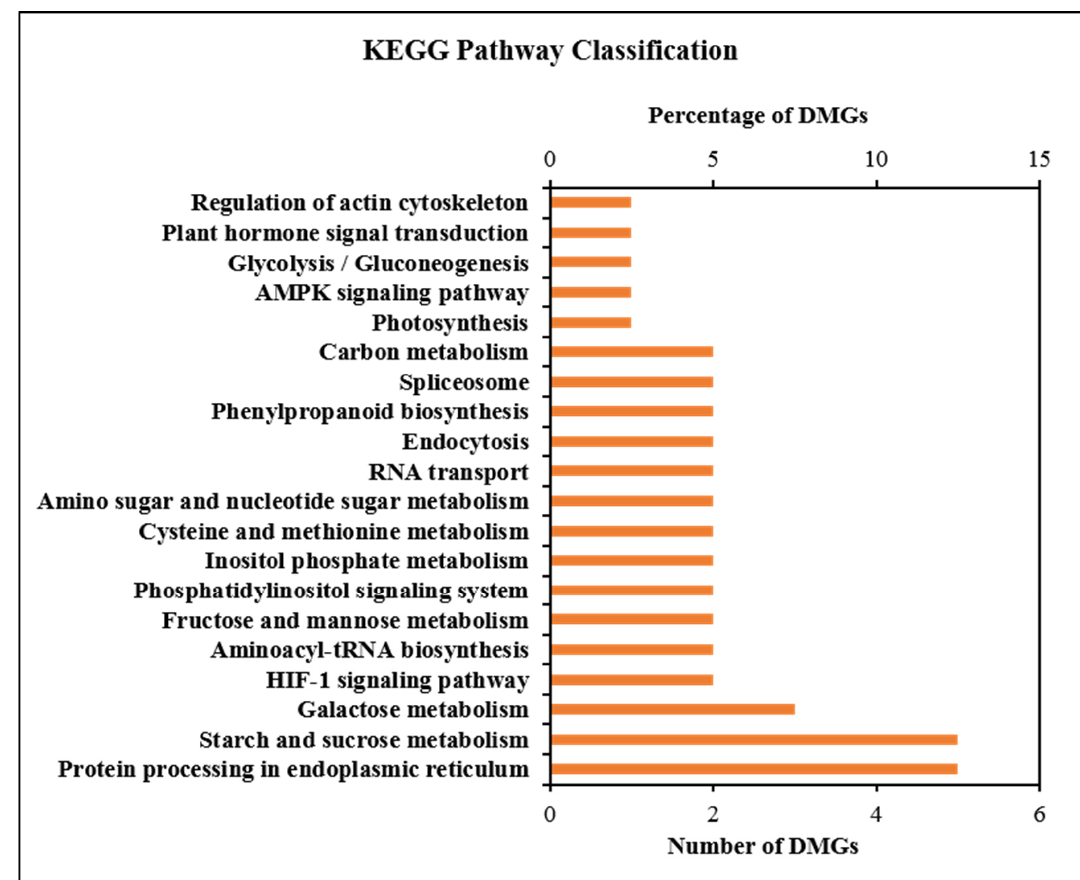
Figure 5. KEGG enrichment analysis of differentially methylated genes (DMGs).